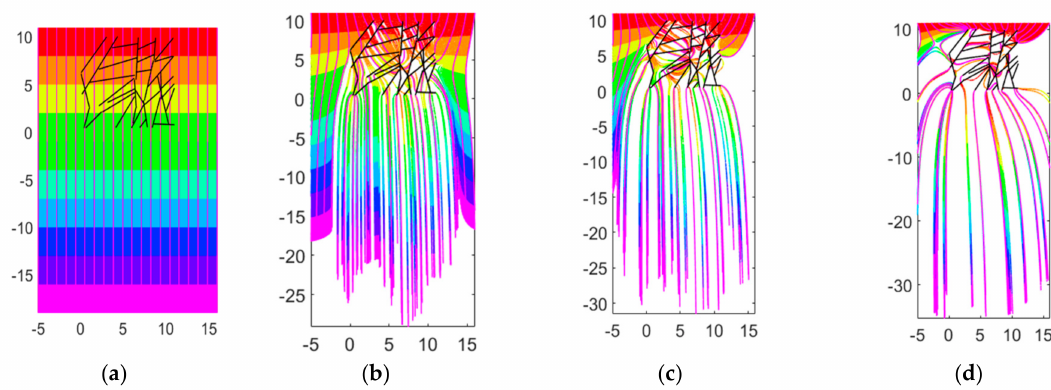
Figure 20. ( a–d ): Case E. Streamlines (magenta) and TOFC (rainbow colors) for the slab with enhance permeability flow channels of Figure 19c simulated for 20 years. The flow channels are deactivated in case a and cases b-d have increasing strengths of the flow channels (scaled by their respective lengths and with attributes for each flow channel presented in Appendix B Table A7).